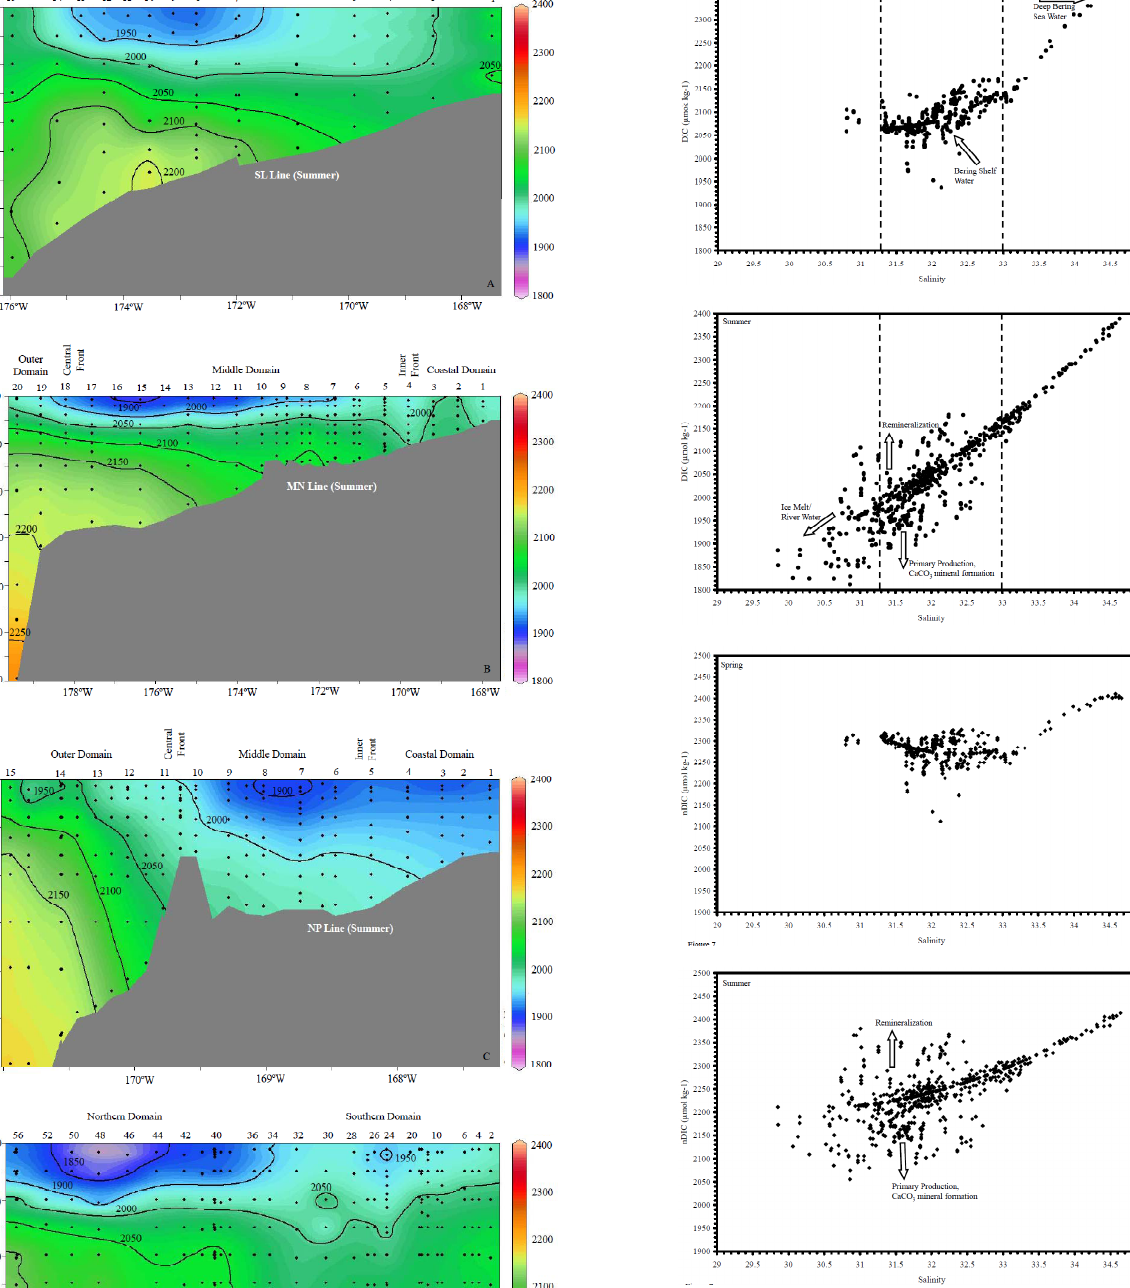
Fig. 7. Spring and summer concentrations of DIC (µmoleskg − 1 ) relative to salinity. (A) Spring. Bering shelf water salinity ranged from 31.3 to 33, with concentrations of DIC from 1950µmoleskg − 1 to 2170µmoleskg − 1 , while deep Bering Sea salin- ity ranged from salinity 33–35, with concentrations of DIC from 2140µmoleskg − 1 to 2380µmoleskg − 1 . (B) Summer. DIC concentrations (µmoleskg − 1 ) relative to salin- ity. Arrows show the relative influence of freshwater input, on both salinity and DIC, whereas productivity decreased DIC and remineralization increased DIC relative to salinity. (C) Spring. Most nDIC concentrations fell within the range of salinities of 31 and 33. (D) Summer. nDIC concentrations relative to salinity decreased from spring. NCPandcarbonatemineralformationdrawsspringtimeclusteringdownasDICiscon- sumed; remineralization distributes the clustering up, as DIC is produced by biological processes and carbonate mineral dissolution. The effects of each process are shown by